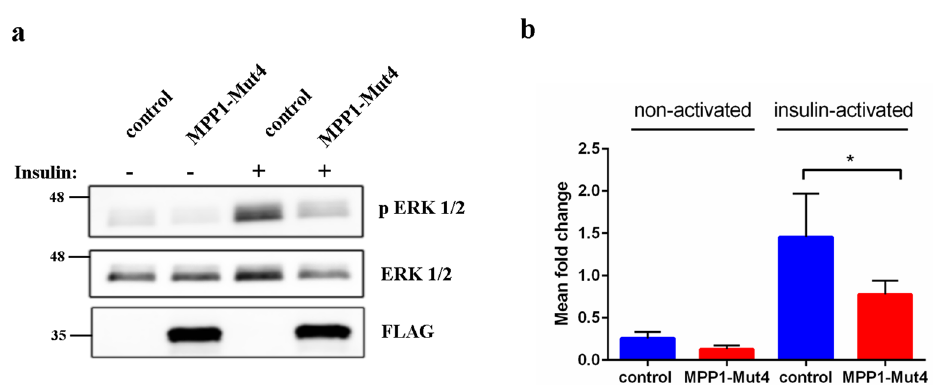
Figure 7. MPP1-Mut4 inhibits signal transduction from raft-dependent IR receptor in HEL cells. Control (FLAG-transfected) and MPP1-Mut4 transfected cells were treated with insulin and the whole-cell extracts were subjected to Western blot analysis and probed with antibodies against indicated proteins ( a ). Quantification of the relative phosphorylation levels of ERK1/2 in control and MPP1-Mut4 transfected cells (average ± S.D. from four independent experiments; statistical analysis was performed using non-parametric t-test p < 0.05) were performed ( b ). Uncropped blots are shown in Fig.